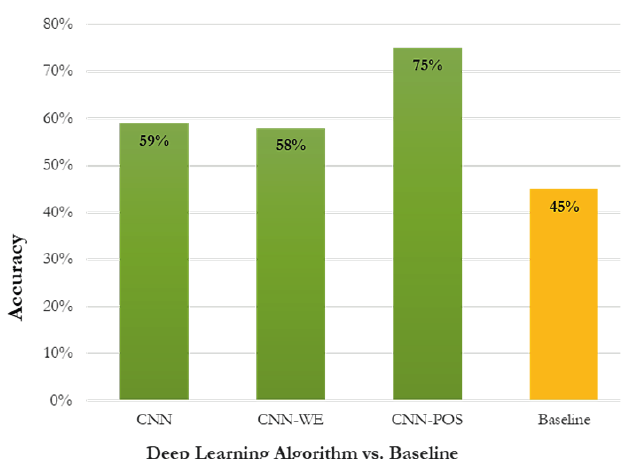
Fig. 8. Accuracy of ML models vs. baseline model for the aspect detection phase.